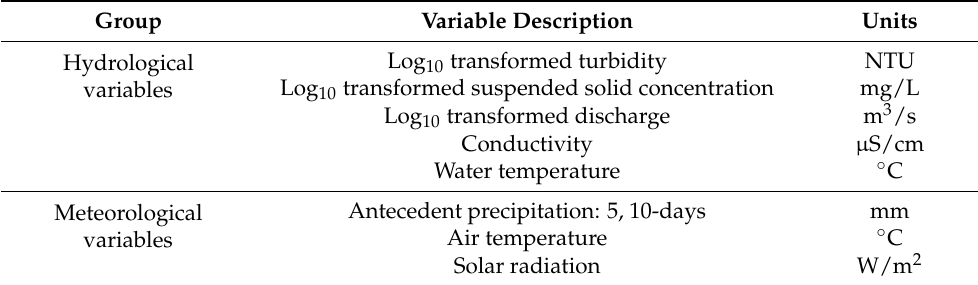
Table 1. Hydrological and meteorological